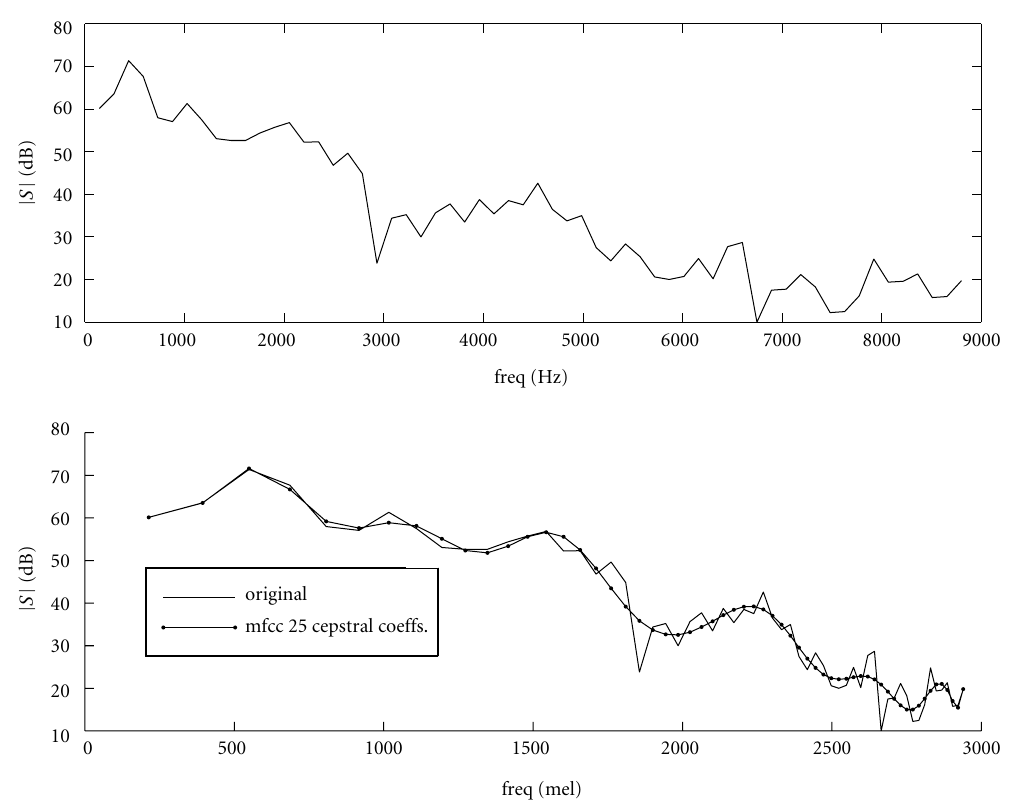
Figure 1: Sustain average spectral envelope of a saxophone tone (upper figure, frequency axis in Hz), and frequency warped mel-cepstrum envelope (lower figure, frequency axis in